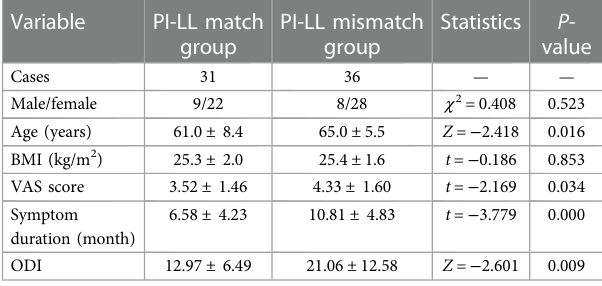
TABLE 1 Comparison of baseline data between PI-LL match and PI-LL mismatch groups. Variable